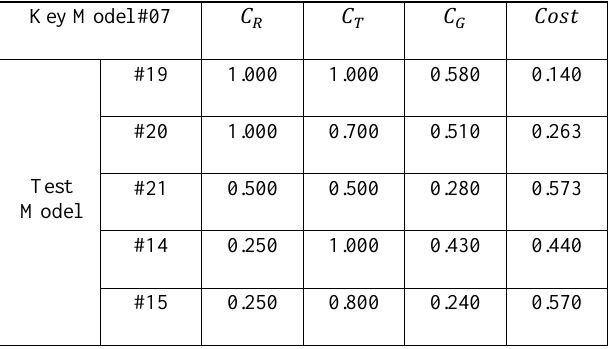
Table 3. Quantitative assessment of aligning a key model (#07)